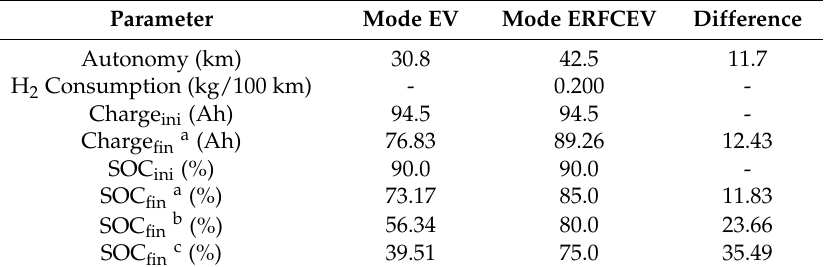
Table 7. Comparison of FCEREV vs. EV.